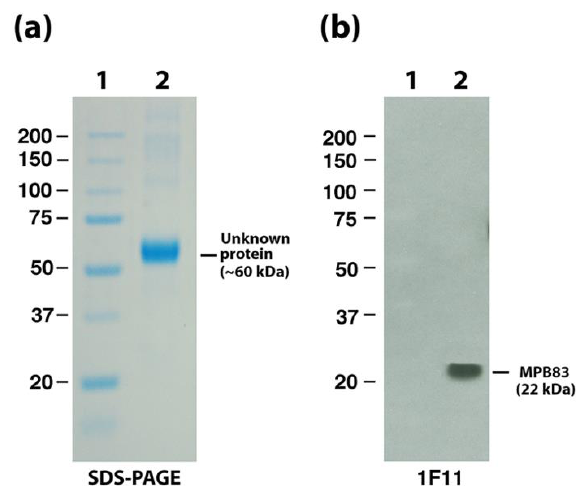
Figure 7. MPB83 is not the most abundant protein in M. bovis EtOH extracts. ( a ) SDS-PAGE analysis of the M. bovis EtOH extract reveals a high abundant protein migrating between the 50 and 75 kDa size markers (lane 2). ( b ) Immunoblot analysis with a monoclonal antibody to MPB83 (1F11) identifies the 22-kDa MPB83 protein in the EtOH extract (lane 2). Protein size markers are loaded in lane 1 with sizes identified in kilodaltons (kDa) in the left margins. The unknown and MPB83 proteins are indicated in the right margins.